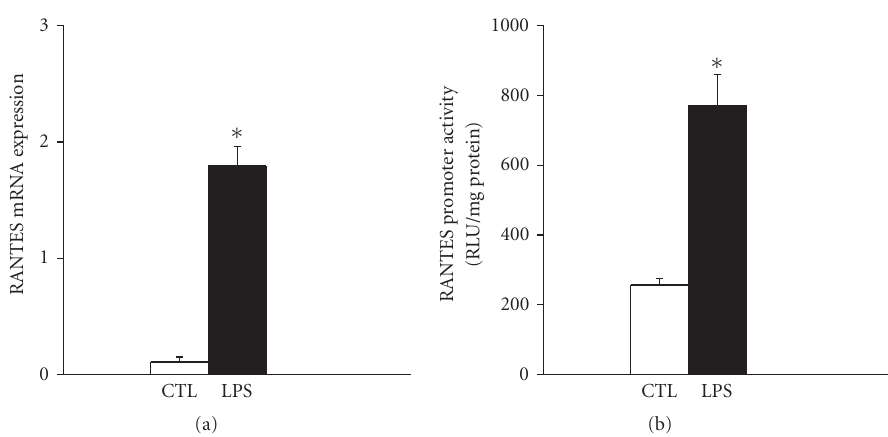
Figure 4: LPS is able to activate upregulation of the RANTES gene in cultured muscle cells. (a) RANTES mRNA levels in primary diaphragmatic myotubes under basal conditions (CTL) and in response to a 4-hour period of exposure to LPS (1 μ g/mL). All data are normalized to the L32 housekeeping gene. ∗ P < . 05 for comparisons to the control (CTL) condition. (b) RANTES promoter activation as reflected by luciferase activity in C2C12 muscle cells previously transfected with a RANTES promoter-luciferase reporter gene plasmid. Myotubes were again analyzed under basal conditions (CTL) and following a 4-hour period of stimulation with LPS (1 μ g/mL). ∗ P < . 05 for comparisons to the control (CTL) condition.